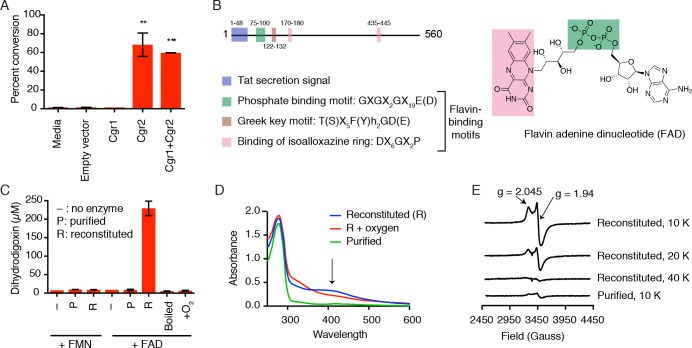
Cgr2 is sufficient for digoxin reduction and requires FAD and [4Fe-4S] cluster(s) for activity.(A) Whole cell assays using R. erythropolis expressing Cgr1 and Cgr2 constructs demonstrated that Cgr2 is sufficient for reducing digoxin. Data represents the mean ± SEM (n = 3 biological replicates). Asterisks indicate statistical significance of each variant as compared to empty vector by Student’s t test (**p<0.01, ***p<0.001) (Figure 2—source data 1). (B) Annotation and amino acid numbering of Cgr2, including the predicted Tat secretion signal and three conserved flavin-binding motifs from the glutathione reductase family (X = any amino acid; h = hydrophobic residue). (C) In vitro activity of Cgr2 for digoxin reduction using reduced methyl viologen as an electron donor, analyzed by liquid chromatography-tandem mass spectrometry (LC-MS/MS). [Fe-S] cluster reconstitution, FAD, and anaerobic conditions are required for Cgr2 activity. Data represents the mean ± SEM (n = 3 independent experiments) (Figure 2—source data 2). FAD = flavin adenine dinucleotide; FMN = flavin mononucleotide. (D) Ultraviolet-visible (UV-Vis) absorption spectra of Cgr2 revealed an oxygen-sensitive peak centered around 400 nm that increased upon [Fe-S] cluster reconstitution, supporting the presence of [4Fe-4S] clusters in Cgr2. (E) Electron paramagnetic resonance (EPR) spectra of sodium dithionite-reduced Cgr2 reconstituted with iron ammonium sulfate hexahydrate ((NH4)2Fe(SO4)2·6H20) and sodium sulfide (Na2S·9H20). G-values and decreased EPR signal intensity at higher temperatures (10 – 40 K) indicated the presence of low potential [4Fe-4S]1+ clusters. Experimental conditions were microwave frequency 9.38 GHz, microwave power 0.2 mW, modulation amplitude 0.6 mT, and receiver gain 40 dB.10.7554/eLife.33953.011Figure 2—source data 1.Digoxin metabolism by R. erythropolis overexpressing Cgr proteins.10.7554/eLife.33953.012Figure 2—source data 2.Digoxin metabolism by Cgr2 in vitro.10.7554/eLife.33953.013Figure 2—source data 3.Examples of [2Fe-2S], [3Fe-4S], and [4Fe-4S] cluster binding motifs that are not found in Cgr2 (Zhang et al., 2010; Nakamaru-Ogiso et al., 2002; Lee et al., 2004; Pandelia et al., 2011; Schnackerz et al., 2004; Leech et al., 2003; Gorodetsky et al., 2008; Lee et al., 2010; Weiner et al., 2007; Klinge et al., 2007; Dickert et al., 2002; Conover et al., 1990; Schneider and Schmidt, 2005; Iwasaki et al., 2000; Banci et al., 2013; Dailey and Dailey, 2002; Jung et al., 2000).10.7554/eLife.33953.014Figure 2—source data 4.Digoxin metabolism by R. erythropolis overexpressing Cgr2 cysteine to alanine point mutants.10.7554/eLife.33953.015Figure 2—source data 5.Digoxin metabolism by Cgr2 cysteine to alanine point mutants in vitro.